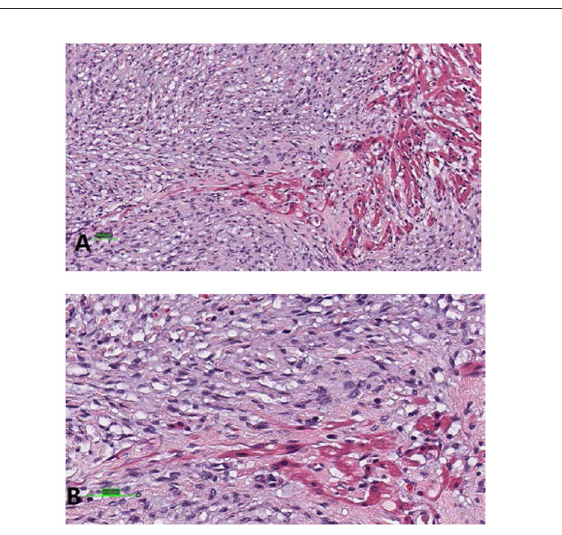
FIGURE4 Examination under a light microscope (A); Magnification: 20x, and (B) 40x (hematoxylin and eosin staining).